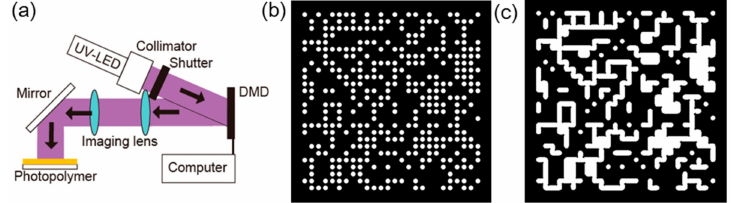
Figure 5. ( a ) Optical setup for pattern irradiation and irradiation patterns for ( b ) Gaussian-like and ( c ) continuous Gaussian-like random phase